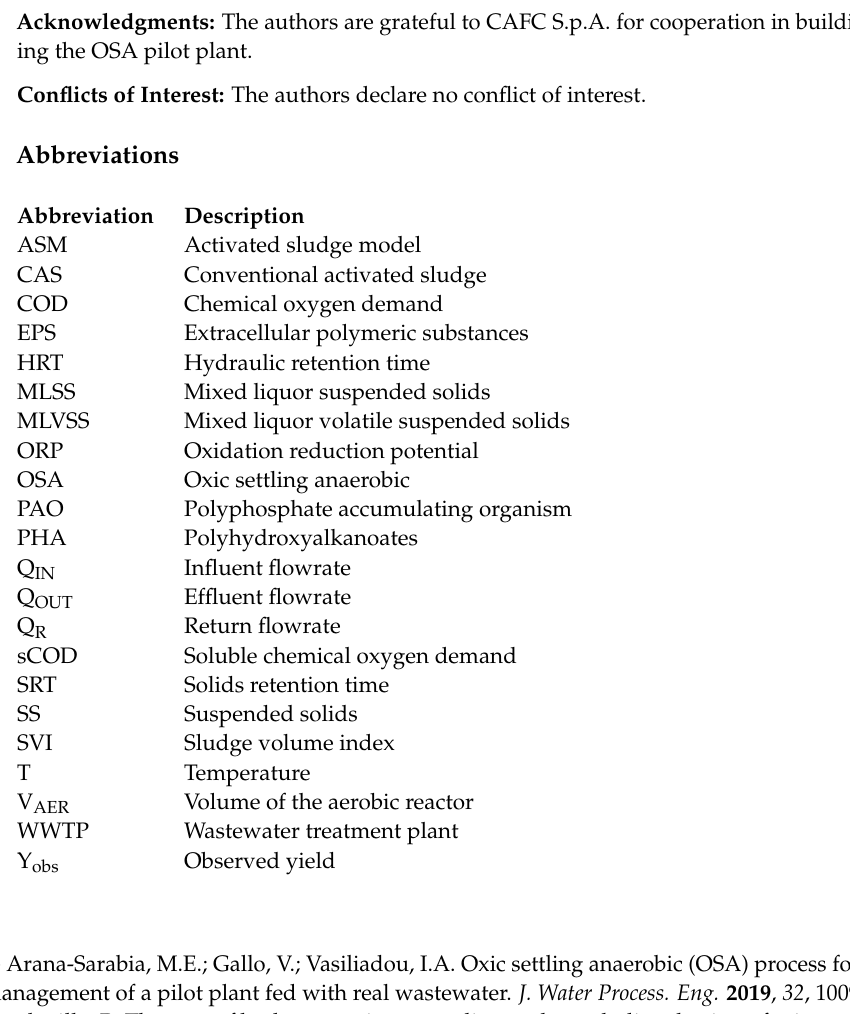
riod VI—Effluent simulated concentrations vs. measured; Figure S10: Period VI—SHT simulated concentrations vs.